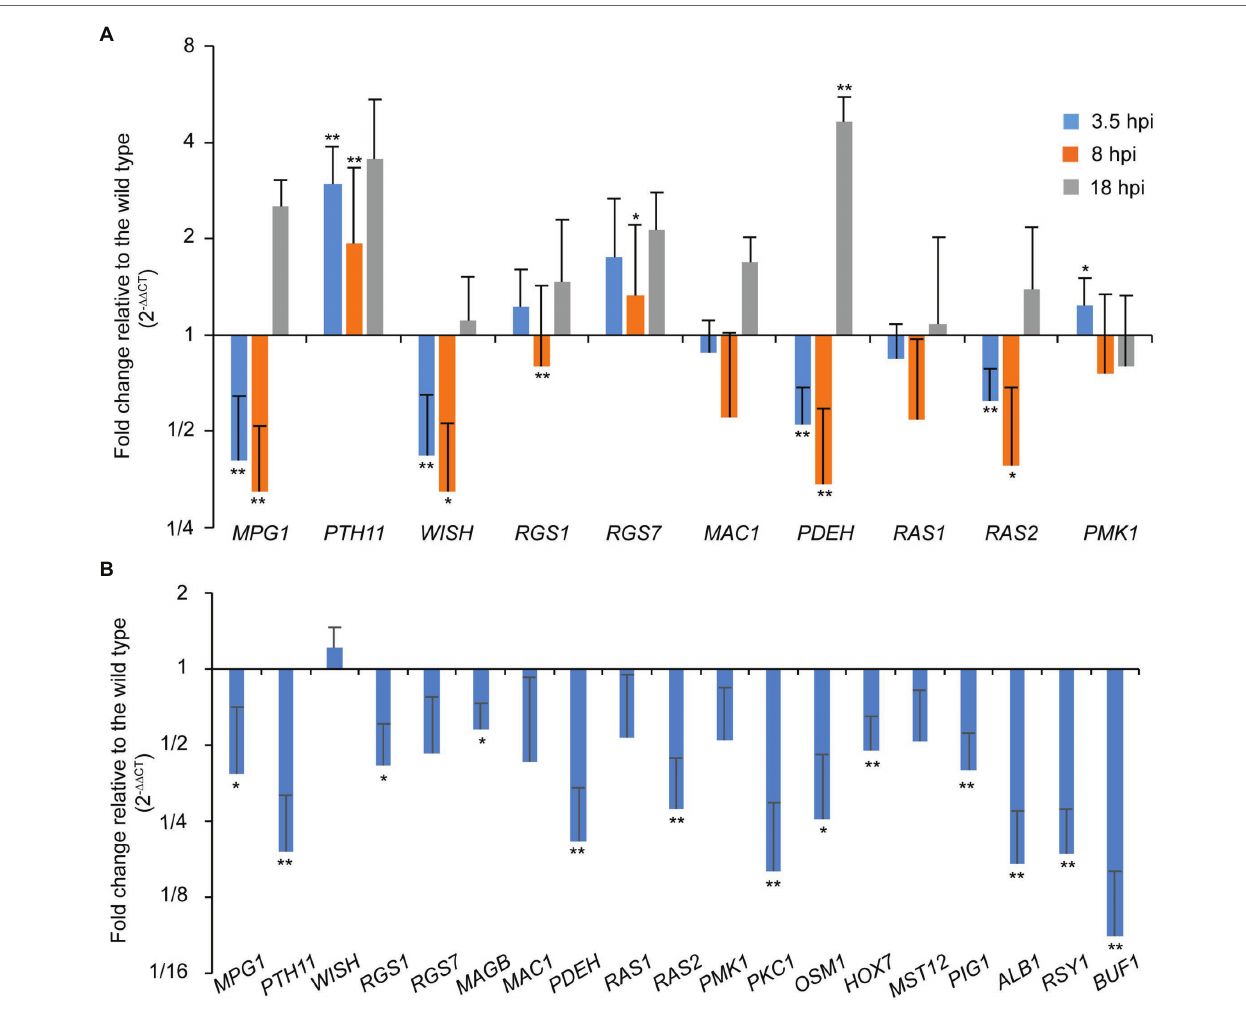
FIGURE 5 | PoRal2 is required for the expression of genes involved in appressorium formation in P. oryzae . (A) Relative mRNA expression levels in germinating spores at 3.5, 8, and 18 hpi of the ∆ Poral2 strain. (B) Relative mRNA expression levels in the aerial hyphae in the ∆ Poral2 strain. Transcript levels of MPG1 , PTH11 , WISH , RGS1 , RGS7 , MAGB , MAC1 , PDEH , RAS1 , RAS2 , PMK1 , PKC1 , and OSM1 genes involved in cAMP signaling and MAP kinase cascade pathways, and PIG1 , ALB1 , BUF1 , and RSY1 genes involved in melanin synthesis were determined in the wild-type and ∆ Poral2 strains by RT-qPCR. The reference genes used were ACTIN and 40S . Significant differences compared with the wild type were estimated by Tukey’s HSD test: * p < 0.05 and ** p <